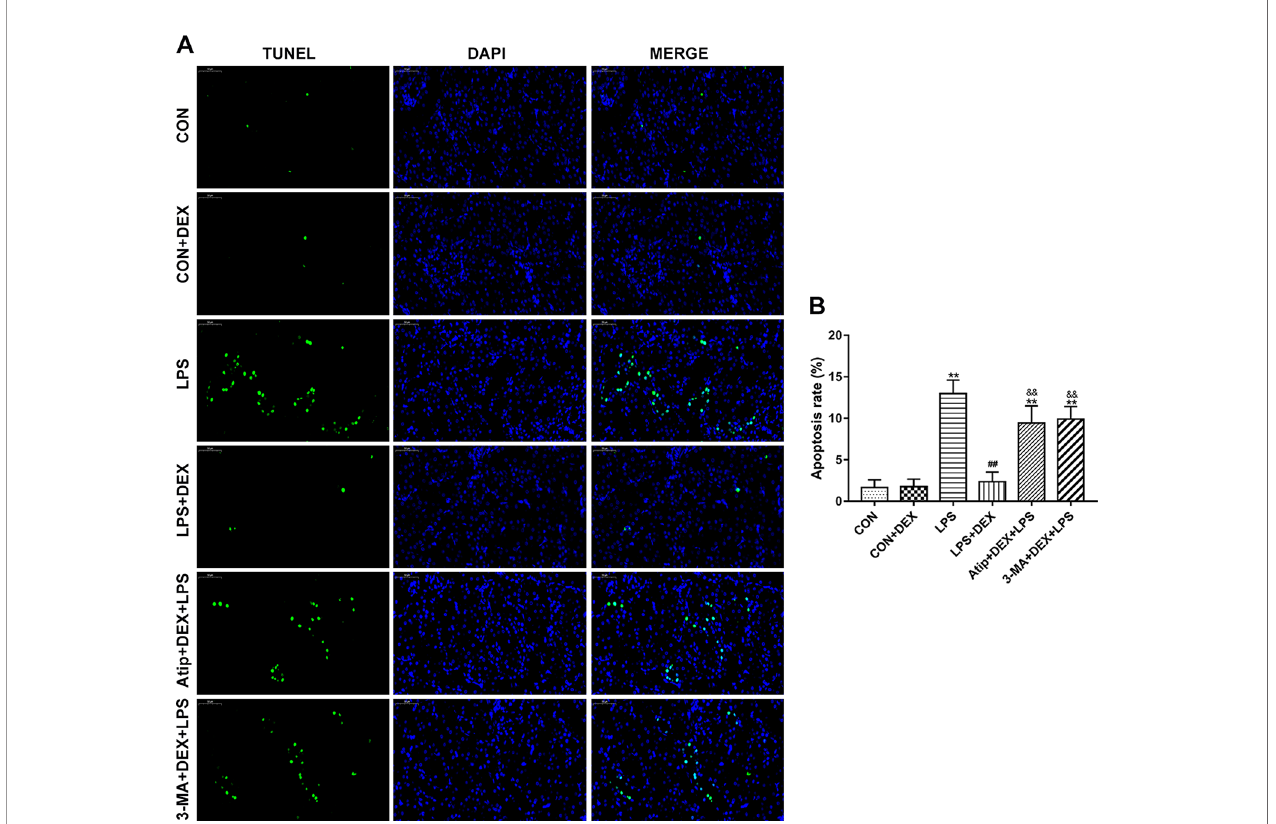
FIGURE 4 | Effect of DEX on renal apoptosis. (A) Representative images of TUNEL assay in renal tissue. Bar: 50 m m. (B) TUNEL-positive cells rate in kidney tissues. Data are expressed as mean ± SEM (n = 6). **p < 0.01 versus CON group. ##p < 0.01 versus LPS group. &&p < 0.01 versus DEX + LPS ( Figure 8A ). In the LPS group, the phosphorylation levels of PI3K, AKT, and mTOR were increased compared with the CON group. However, pretreatment with DEX reduced these protein phosphorylation levels compared with the LPS group, and Atip reversed the effects of DEX. These results indicate that DEX inhibited the PI3K/AKT/mTOR pathway via the a 2 -AR.